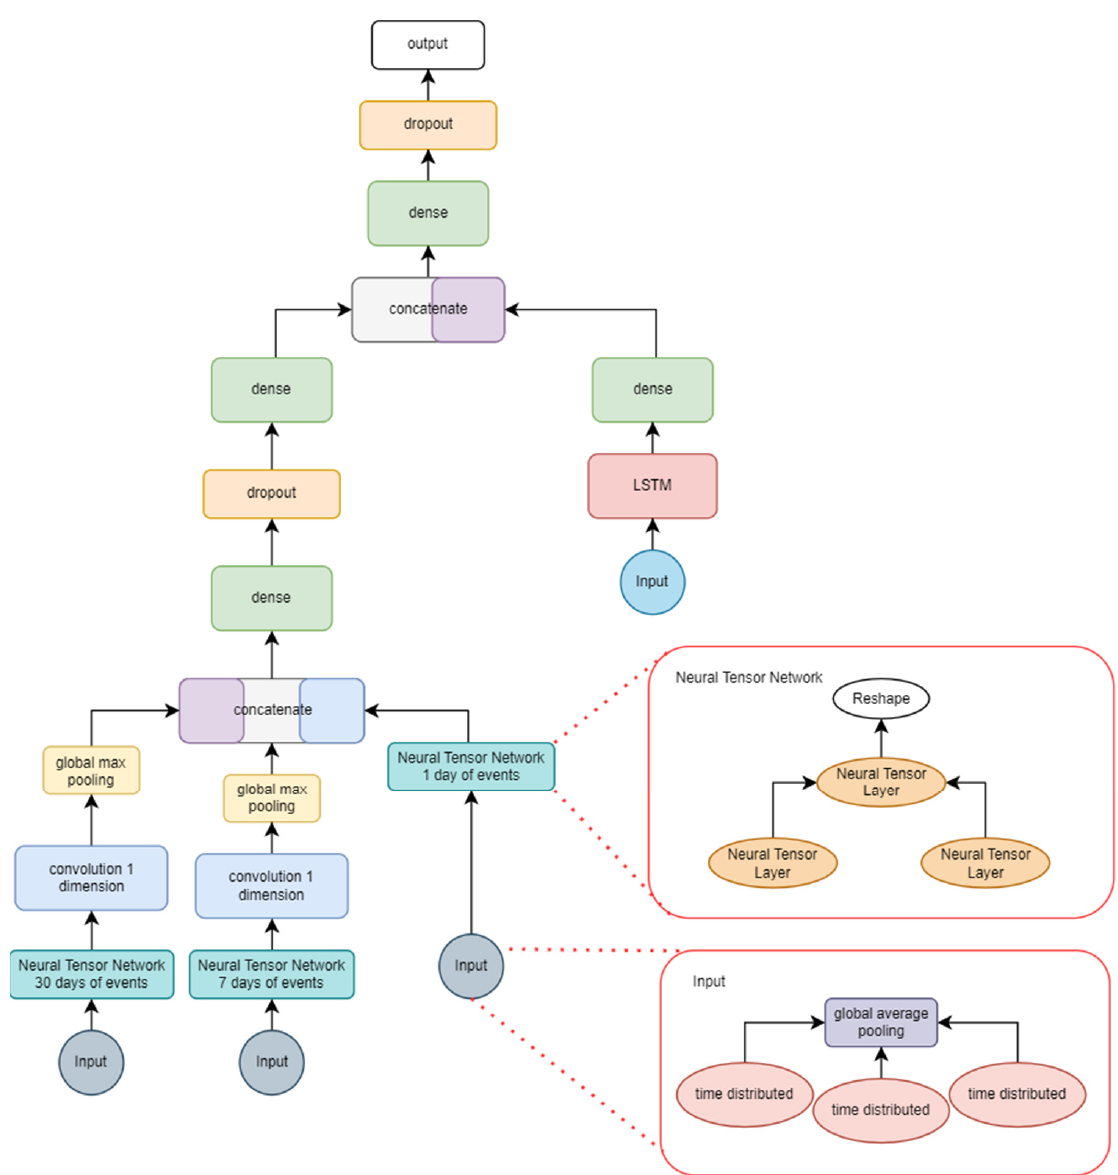
Figure 7. Implemented LSTM ‐ CNN with stock data. Figure 7. Big Data storage